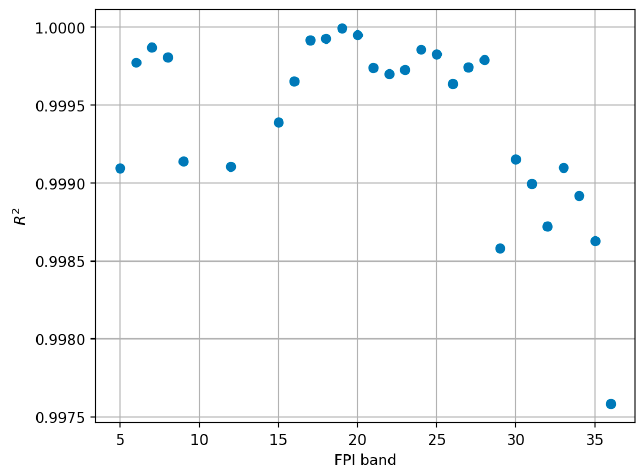
Figure 14. R 2 values for linear fit between adjusted sensor radiance (10 ms sensor integration times) and NPL reference radiance. Stable bands only.